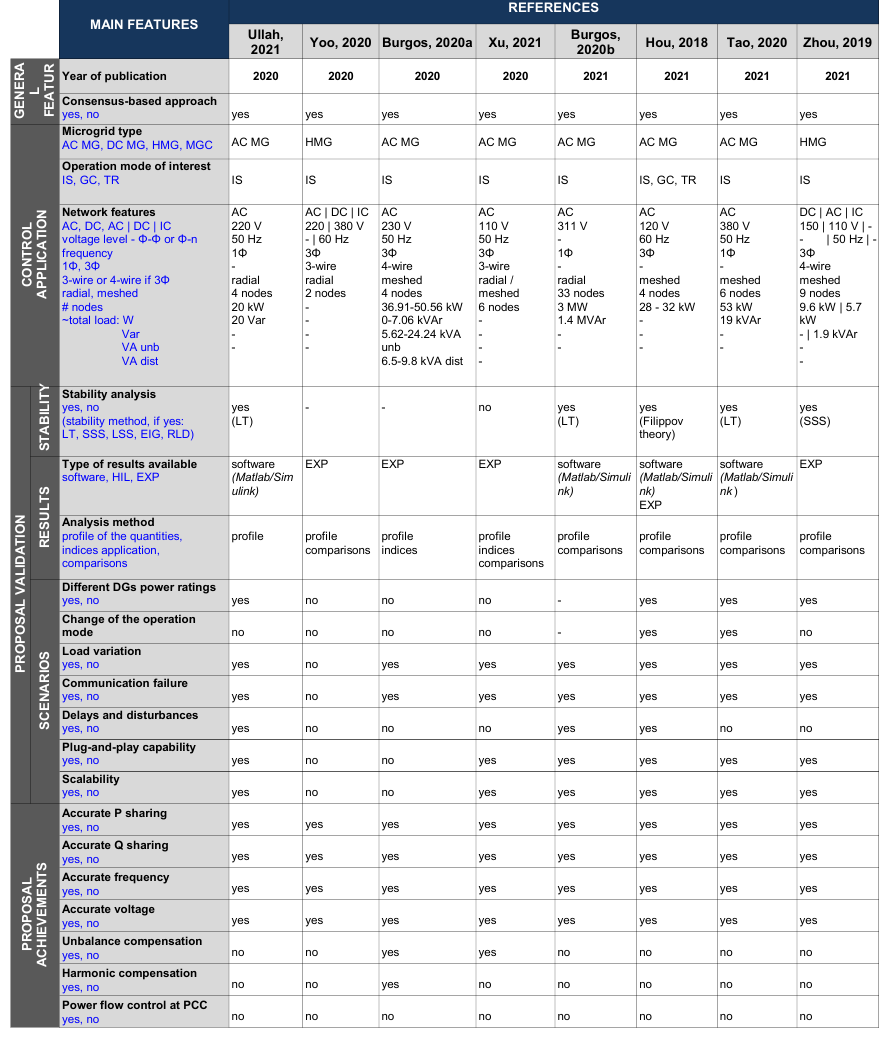
Figure 15. Publications on consensus-based control systems for MGs: general features of the control